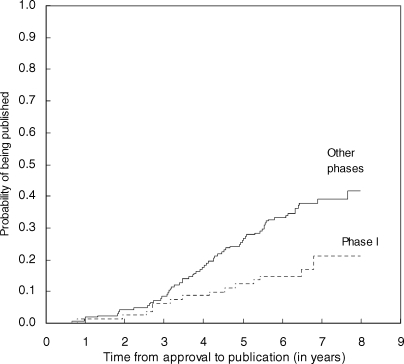
Time from Ethical Approval to Publication for Phase I Versus Phase II–IV Trials